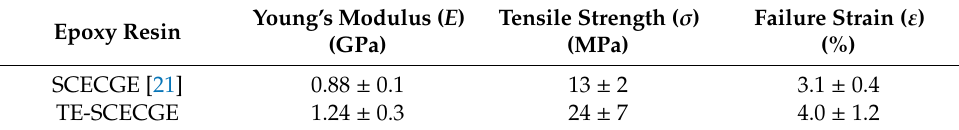
Table 3. Comparison of the mechanical properties as obtained via tensile